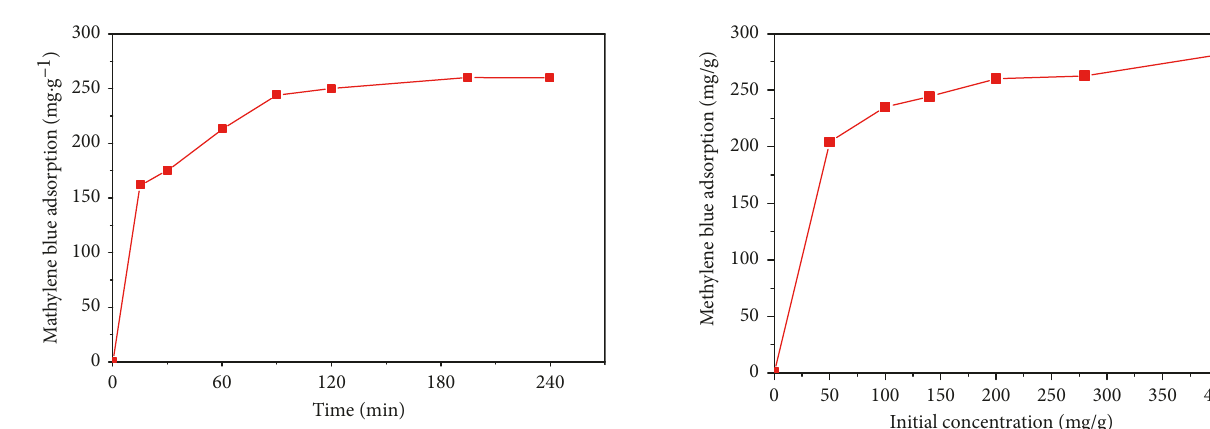
Figure 6: Effect of contact time on the methylene blue adsorption